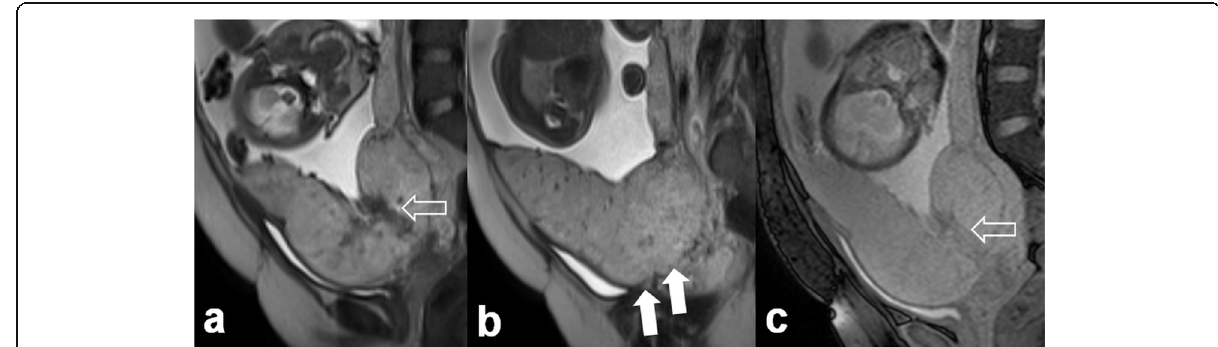
Fig. 3 A 23-year-old woman (gravida − 2) with history of previous Caesarean section. The sagittal T2 HASTE ( a , b ) and SSFP ( c ) MR images show placenta previa with dark bands (open arrows) and loss of uteroplacental interface (arrows). Since placenta accreta was present during elective Caesarean section, uterine artery embolization was performed and she was placed on follow-up